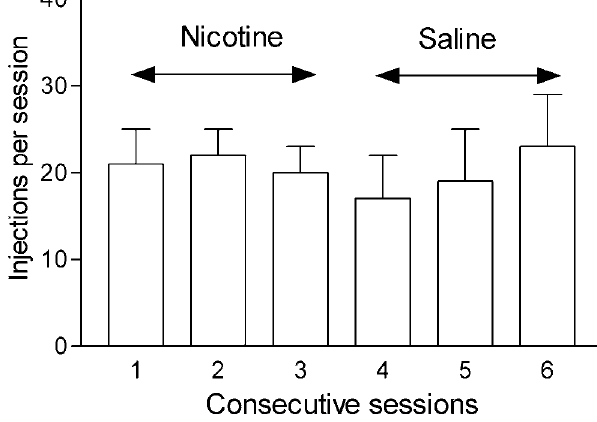
Figure 2. Maintenance of self-administration behavior under the FR 10 schedule during the first experience with saline substitution. Mean number ( 6 SEM) of ratios completed on the active lever during three consecutive session with access to nicotine followed by an additional three sessions with saline substituted for nicotine are shown. The brief 2-sec light stimuli were presented following each ratio completion during both the nicotine and saline sessions. Self-administration behavior was not reduced by the substitution of saline injections for nicotine injections during this first exposure to extinction conditions.